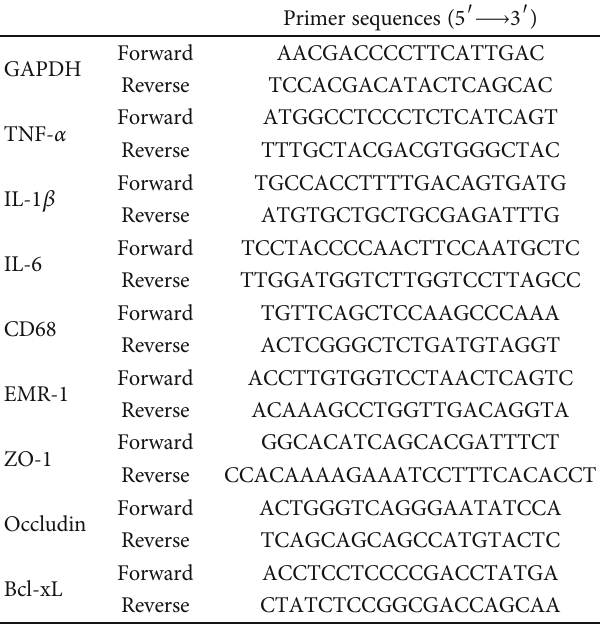
Table 2: Sequences of oligonucleotide primers used for PCR ampli fi cation.